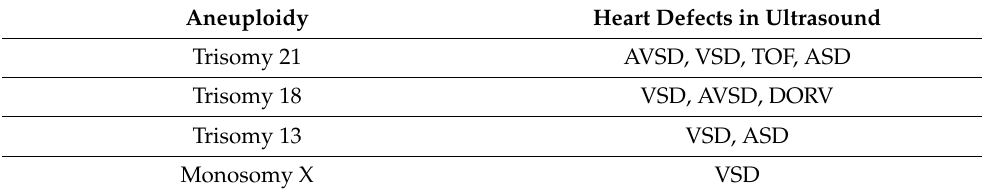
Figure 1. Frequency of chromosomal aneuploidy and microdeletion 22q11.2 in all 176 abnormal results (mosaic trisomy (mos), deletion (del)). Table 1. Specific heart defects of our cases with common aneuploidies.